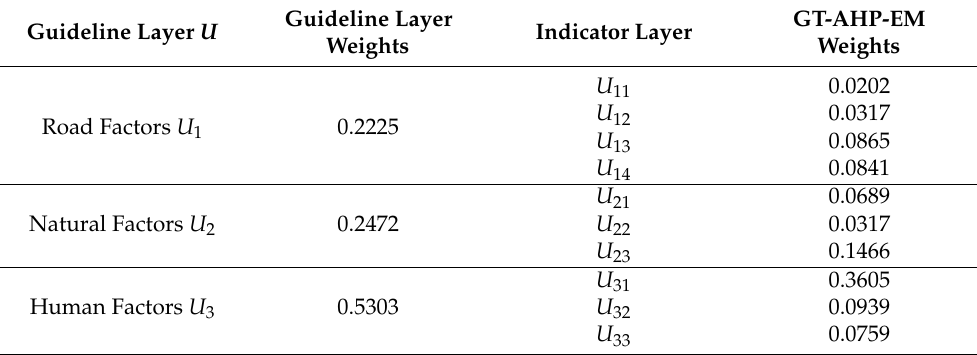
Table 11. The weighting of road traffic trend indicators for the GT-AHP-EM method. Guideline Layer